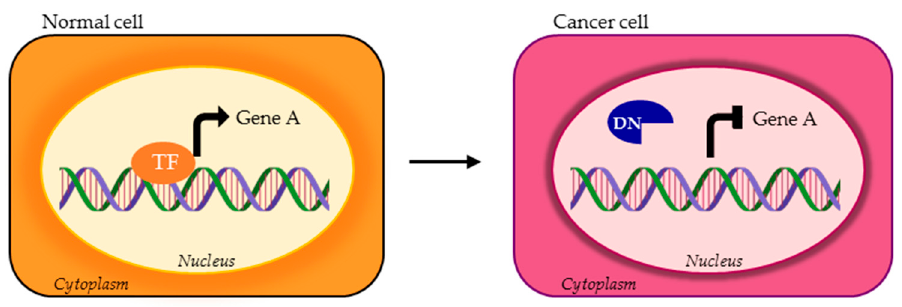
Figure 4. TF isoforms can lose the DBD or other domains required for DNA binding of the canonical TF (orange TF), consequently acting as DNs (blue